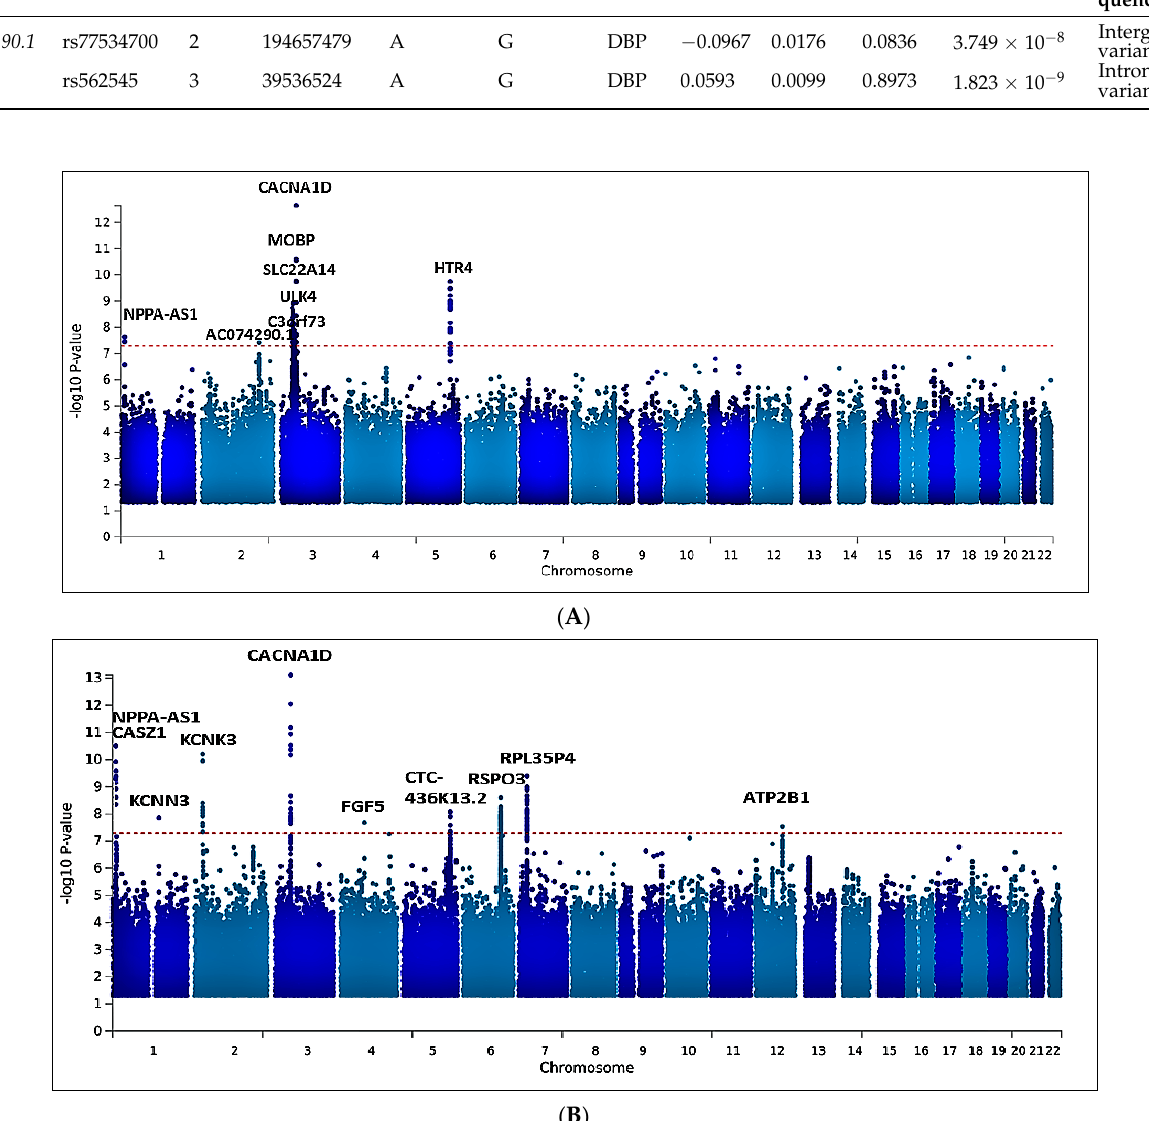
Figure 2. Manhattan plots showing the minimum p -value for the association across ( A ) DBP and ( B ) SBP blood pressure traits, computed using inverse-variance fixed-effect meta-analysis from 75,850 individuals. Each point on the Manhattan plots denotes a variant, with the X -axis representing the genomic position and the Y -axis representing the association level − log 10 ( p -value). The horizontal red line shows the genome-wide significance threshold p -value = 5 × 10 –8